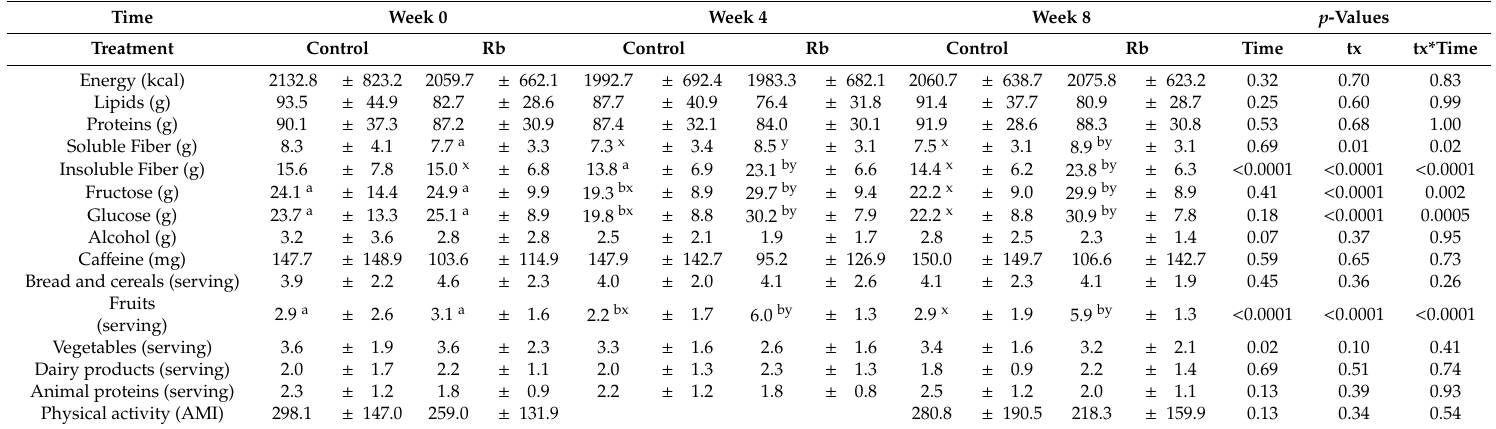
Table 2. Daily dietary intakes by nutrients and by food group over time within and between